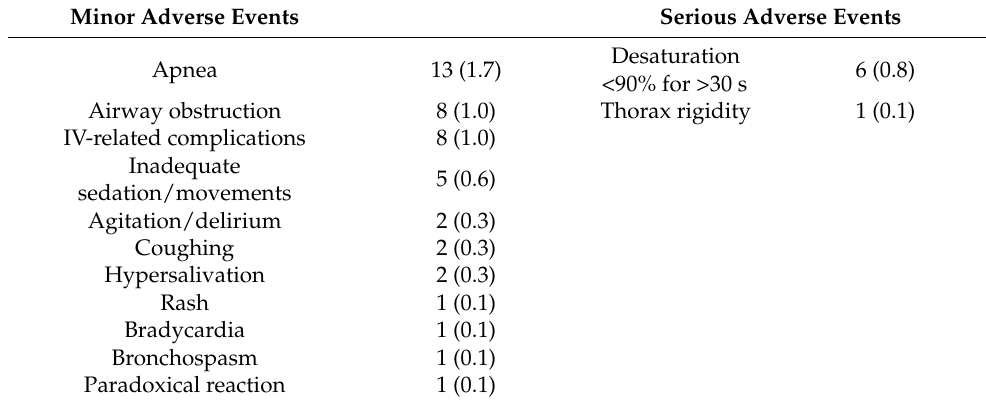
Table 3. Adverse events during sedation.